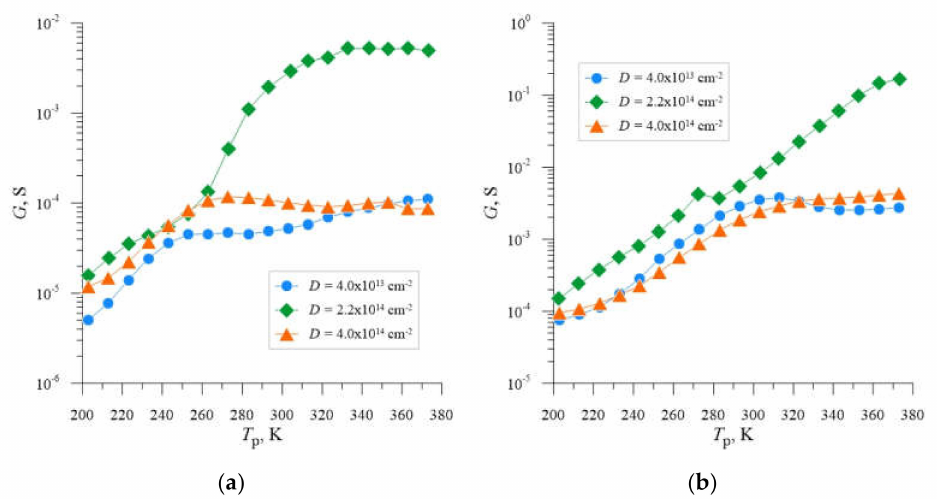
Figure 2. Dependencies G = f( T p ) for silicon with resistivity ρ = 0.4 Ω cm, boron-doped, implanted with Ne + neon ions with energy E = 100 keV, annealed at T a = 598 K, determined for the frequency f of 10 kHz ( a ) and 1 MHz, respectively, ( b ) and three different doses of ions D = 4.0 × 10 13 cm − 2 ; 2.2 × 10 14 cm − 2 ; 4.0 × 10 14 cm − 2